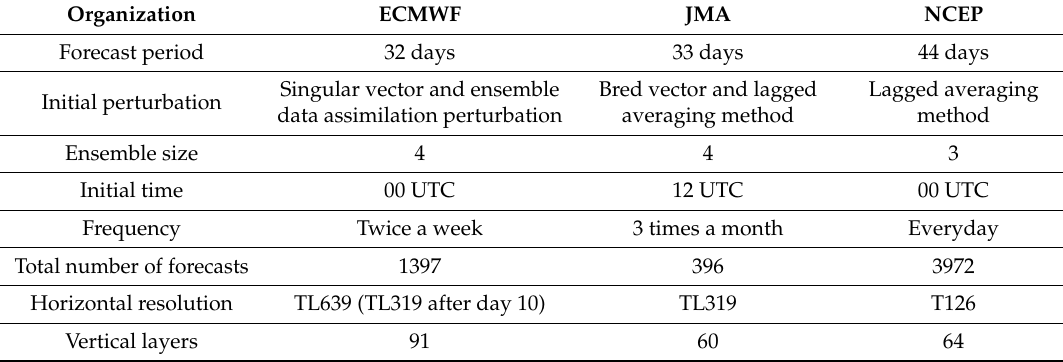
Table 1. Subeasonal-to-seasonal (S2S) forecast models selected in this model. Organization ECMWF